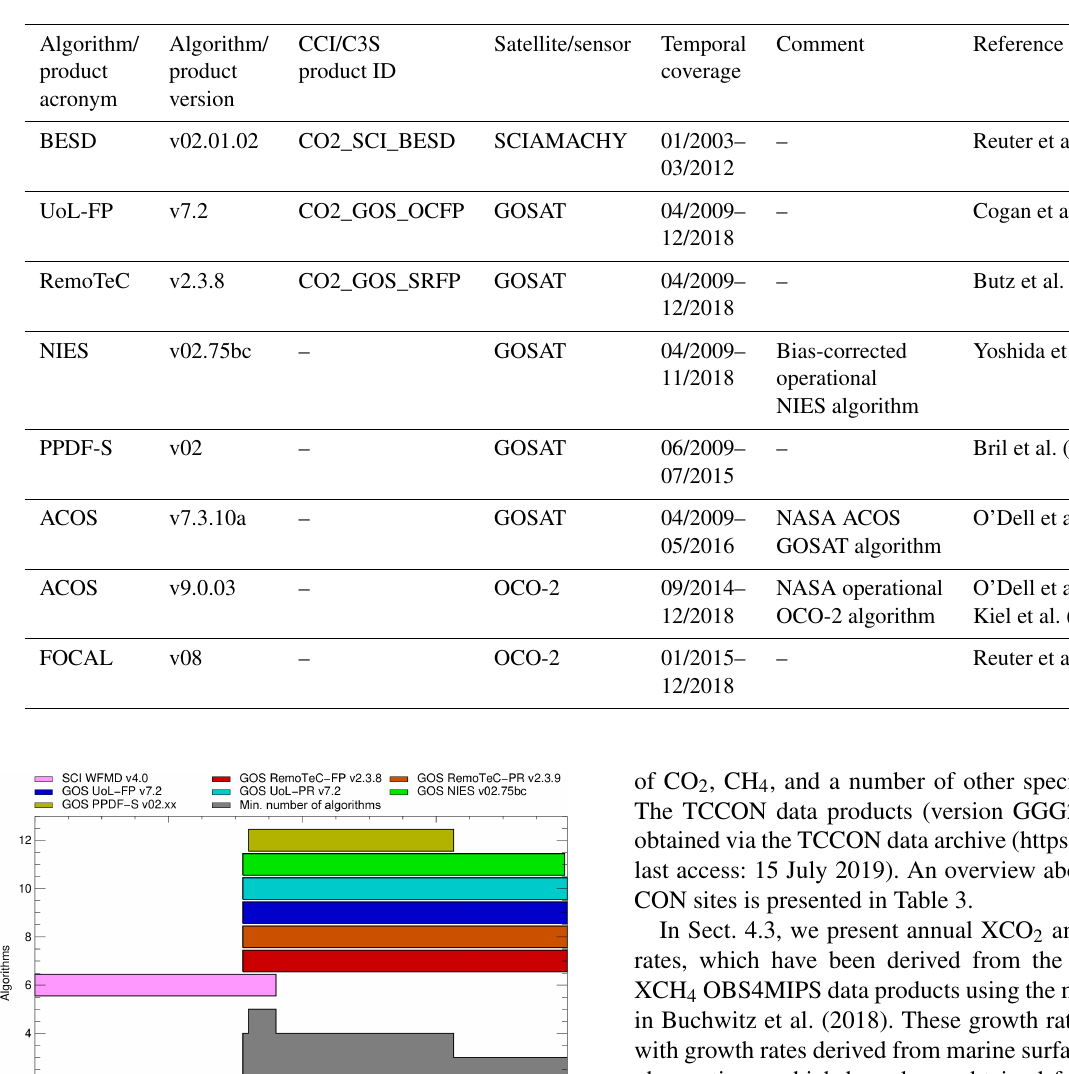
Table 1. Satellite XCO 2 Level 2 (L2) data products used as input for the generation of the merged L2 and L3 XCO 2 version 4.1 data products. For products which have been generated in the framework of the CCI and C3S projects the corresponding product ID is listed (the other products are external products, which have been obtained from the corresponding websites; see Acknowledgements). Temporal coverage indicates the time coverage of the input data sets.